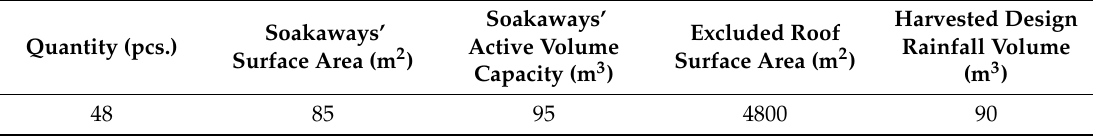
Table 9. Data summary for